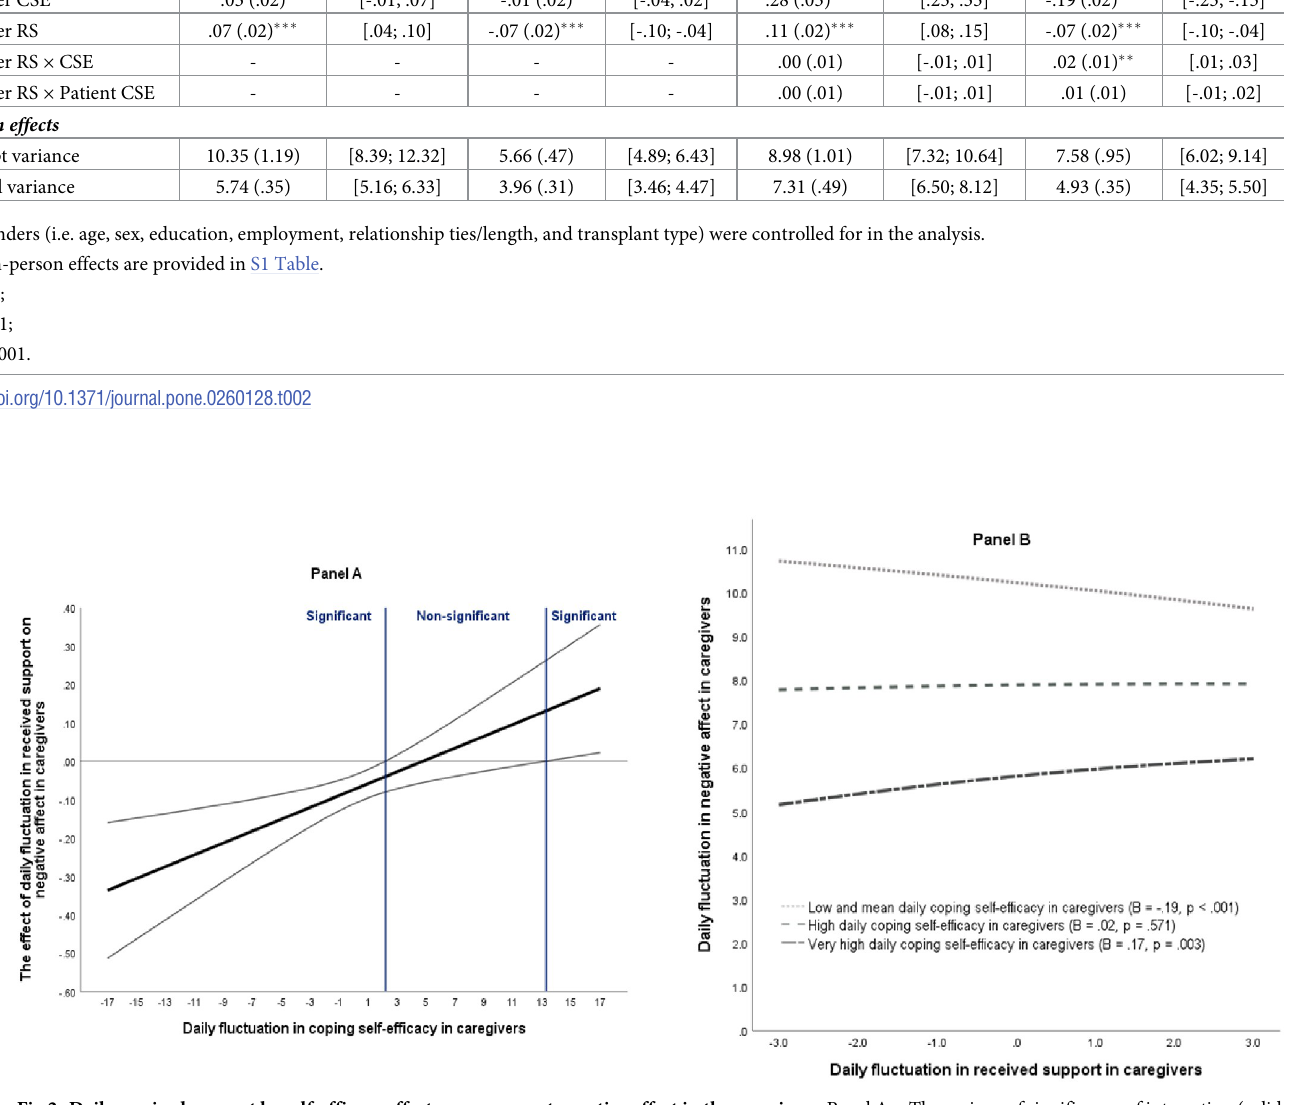
Fig 2. Daily received support by self-efficacy effect on concurrent negative affect in the caregivers. Panel A = The regions of significance of interaction (solid line = interaction effect, thin lines = 95% confidence interval; when the y-zero-line is included in the confidence bands, the effect of daily deviations in received support on negative affect is not significant). Panel B = Simple slopes for the days with typical and lower than typical (below 2.17 on a scale from -17 to 17), higher than typical, and much higher than typical (above 13.28) daily